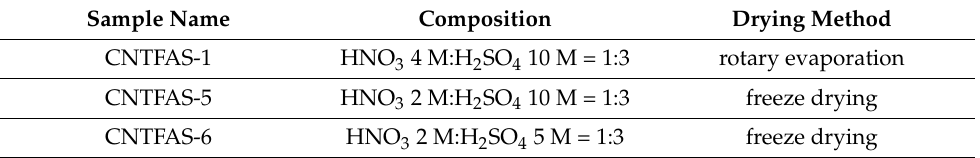
Table 1. Representative samples of CNT functionalized by acid treatment.